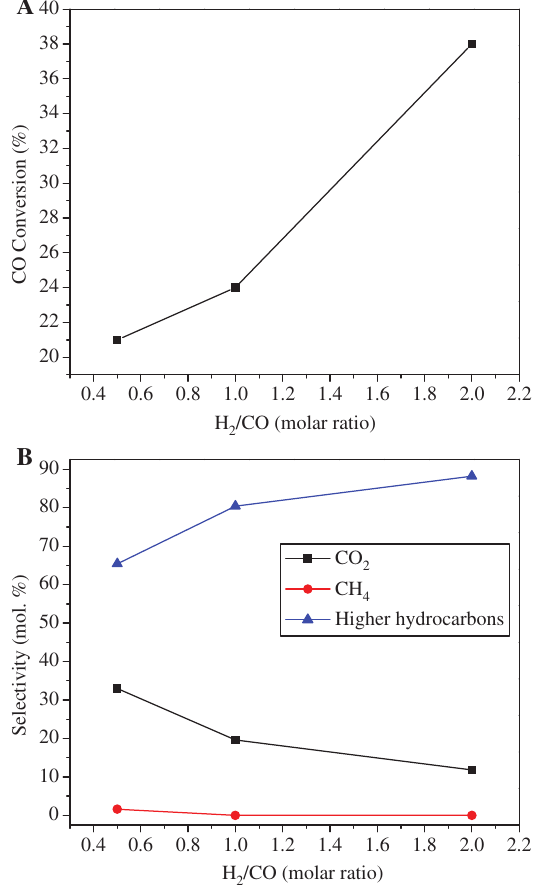
Figure 7 Influence of operating pressure on FTS. (A) Conversion; (B) selectivity. (Wall temperature: 373 K; flow rate: 50 ml/min; H